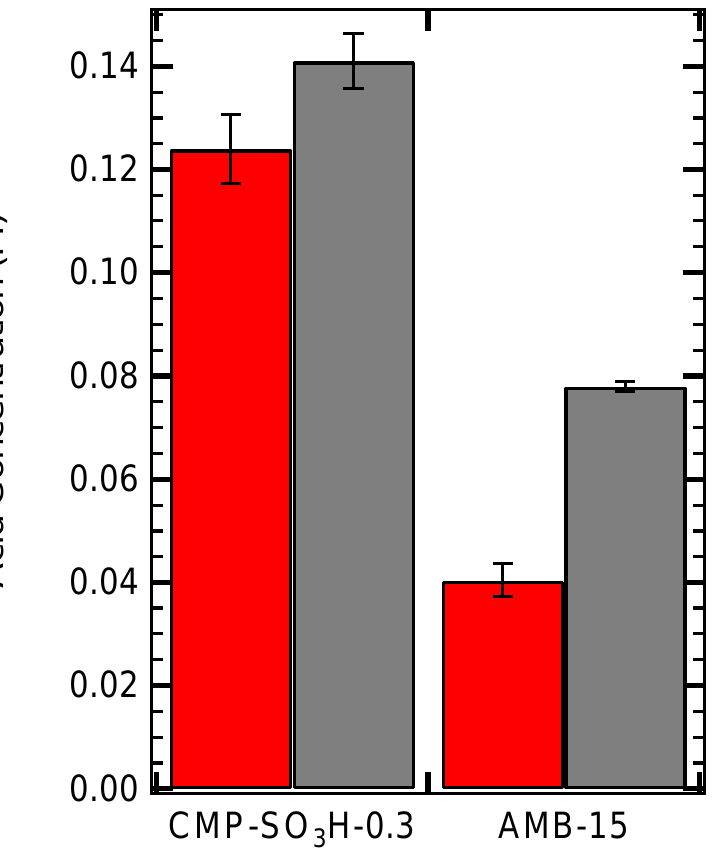
Figure 7. Acid concentration in the liquid medium after hydrothermal treatment of CMP-SO 3 H-0.3 and AMB-15 in the absence of cellulose (red) and after cellulose hydrolysis at the same conditions. Reaction was carried out at 150°C for 10 h.